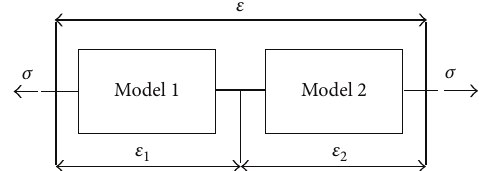
Figure 12: Connection in series of two rheological